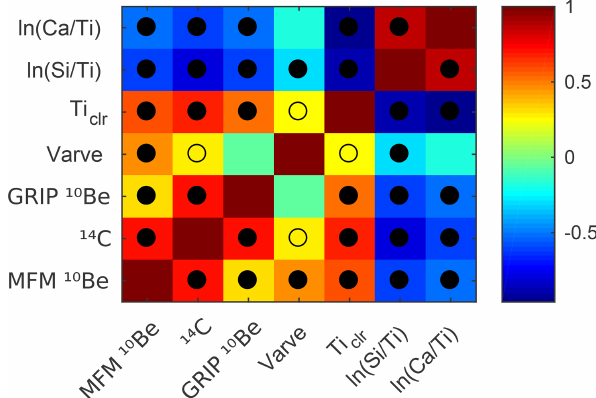
Figure 5. Color-coded correlation matrix between MFM 10 Be con- centration, GRIP 10 Be flux, 14 C production rate data, varve thick- ness, and µ -XRF data from MFM09 (Martin-Puertas et al., 2017). Open and filled circles denote significant correlations with the p < 0 . 1 and the p < 0 . 05 levels, respectively. All data were binned after the resolution of the MFM 10 Be concentration data for the period 11310–11000 years BP, and the Student t test was performed to test the significance